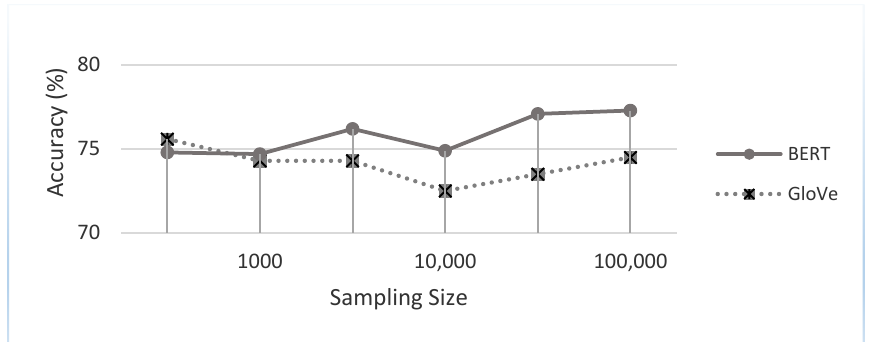
Figure 11. Comparisons of the two word embedding-based deep learning models for our LC5 dataset.